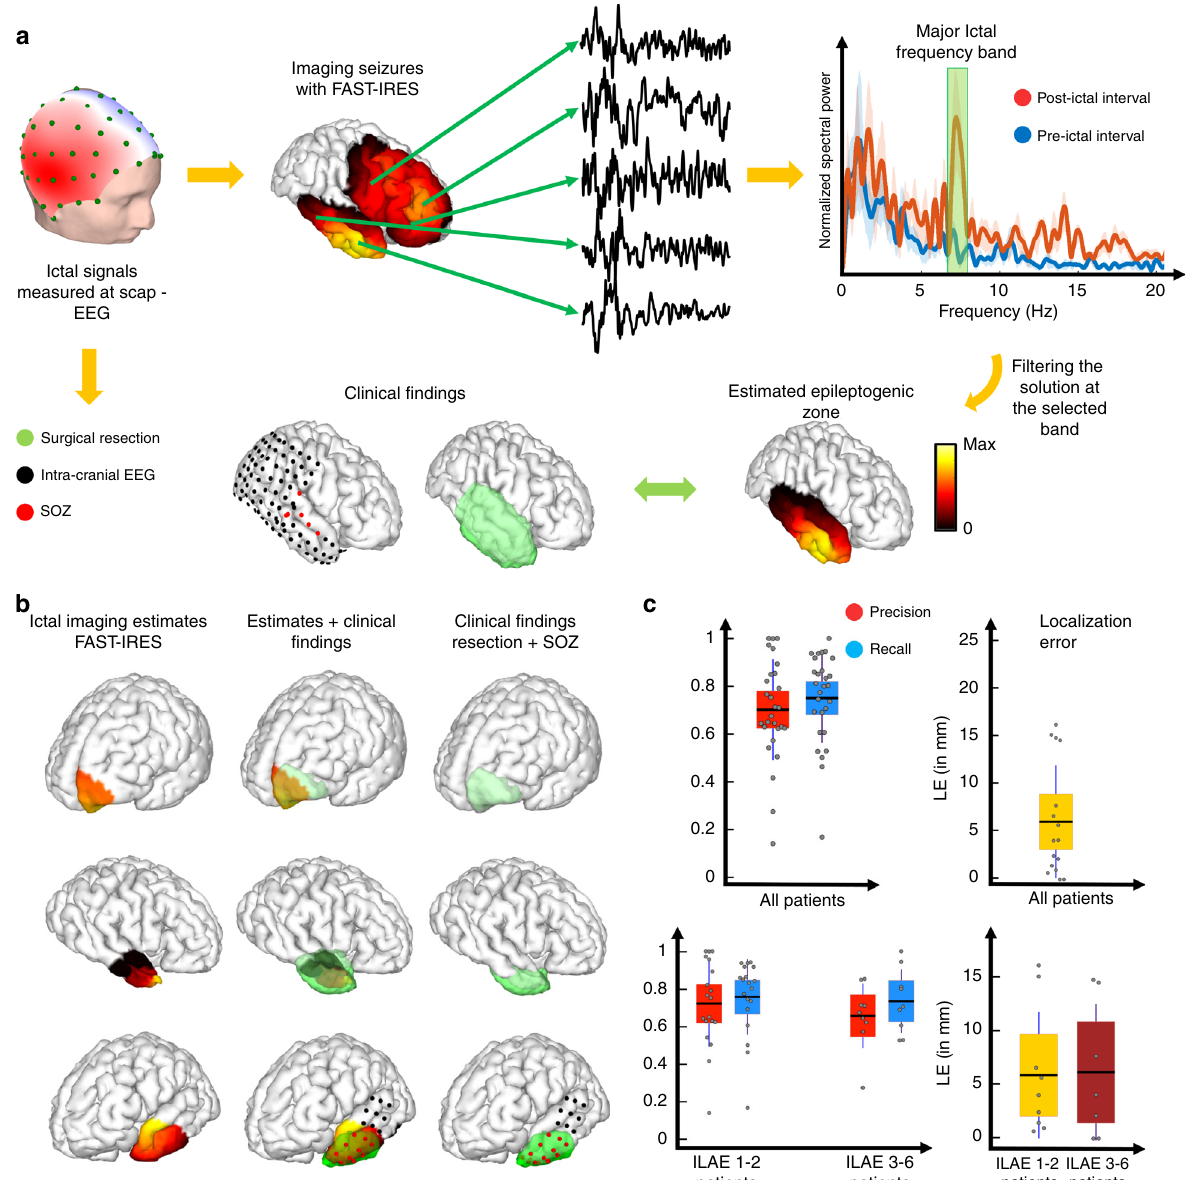
Fig. 5 Ictal-imaging overview and results. a The output of FAST-IRES is a spatiotemporal distribution where spatial distributions correspond to a time- course of activity. To determine the epileptogenic tissue, the dominant ictal frequency is determined and the source signal distribution is fi ltered at this frequency; then the energy of the source signals is calculated at this frequency and for a 1-s interval at seizure onset, to determine the epileptogenic tissue. b Examples of ictal-imaging results along the clinical fi ndings in the same patients. c Quantitative results of ictal-imaging results for all patients (top) and separated based on surgical outcome (bottom). Note that while the color scheme distinguishes precision vs. recall in these patients, for localization error, it is used to denote seizure-free from non-seizure-free patient groups (bottom). Each gray circle corresponds to individual patient ’ s data. The horizontal black bar indicates the mean, the color bars indicate the 95% con fi dence interval for the mean and the dark vertical bars indicate the standard deviation. To compute precision (0.7 ± 0.21) and recall (0.75 ± 0.19), 28 data points were available in total ( n = 28). The same analysis for seizure-free patients yielded higher precision ( n = 19, 0.72 ± 0.23) and recall ( n = 19, 0.76 ± 0.2) compared to the precision ( n = 9, 0.66 ± 0.17) and recall ( n = 9, 0.74 ± 0.17) in the non-seizure-free group. The localization error ( n = 16, 6 ± 5.8 in mm) was calculated from the data of 16 patients ( n = 16). The localization error ( n = 9, 5.9 ± 5.8 in mm) in seizure-free patients was smaller than the same value ( n = 7, 6.1 ± 6.3 in mm) in non-seizure-free patients. Reported values are (mean ± standard deviation). Source data are provided as a Source Data fi